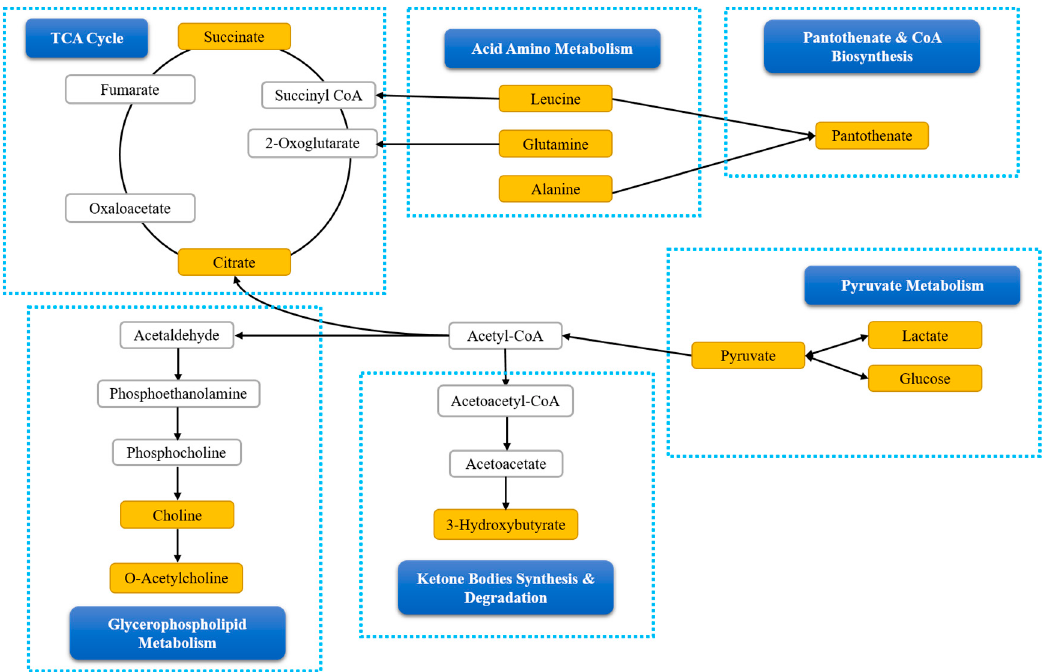
Figure 10. The possible relationship between the altered metabolism pathways via 1 H NMR serum analysis.